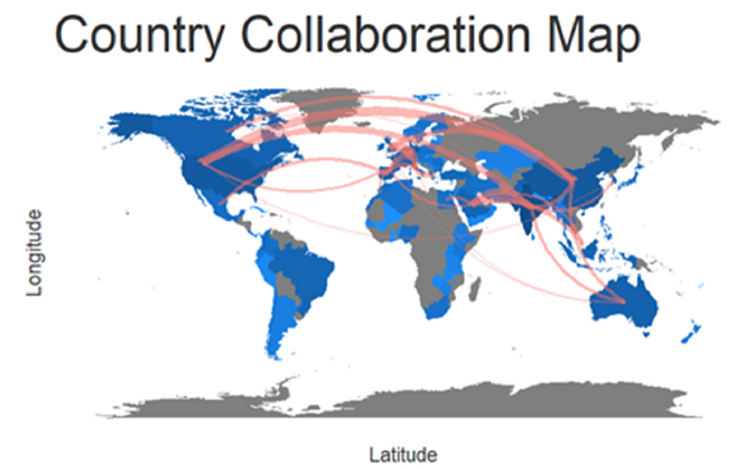
Figure 6. Country collaborations map. Source: Scopus-Biblioshiny.